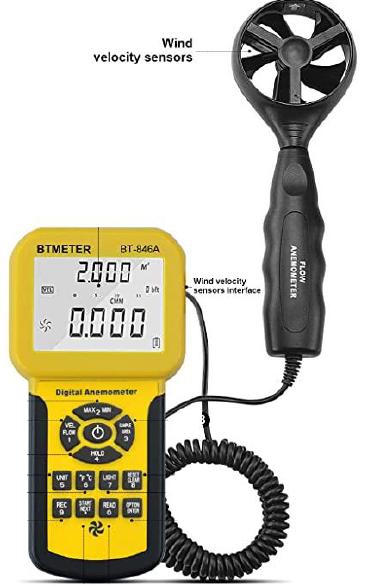
Figure 6. Anemometer: temperature and wind speed sensor.